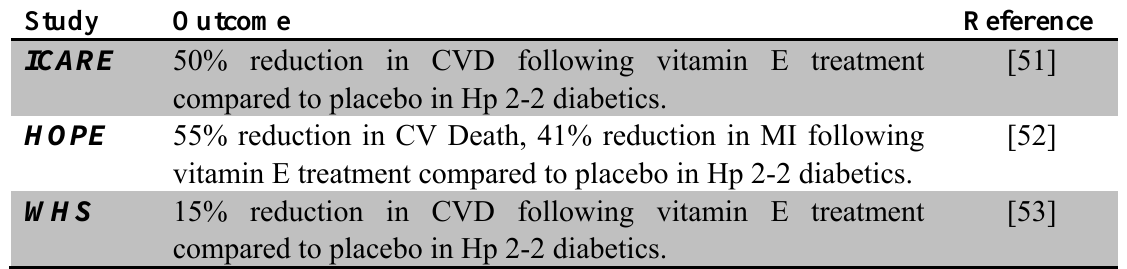
Table 1. Pharmacogenetic interaction between the Hp 2-2 genotype and vitamin E